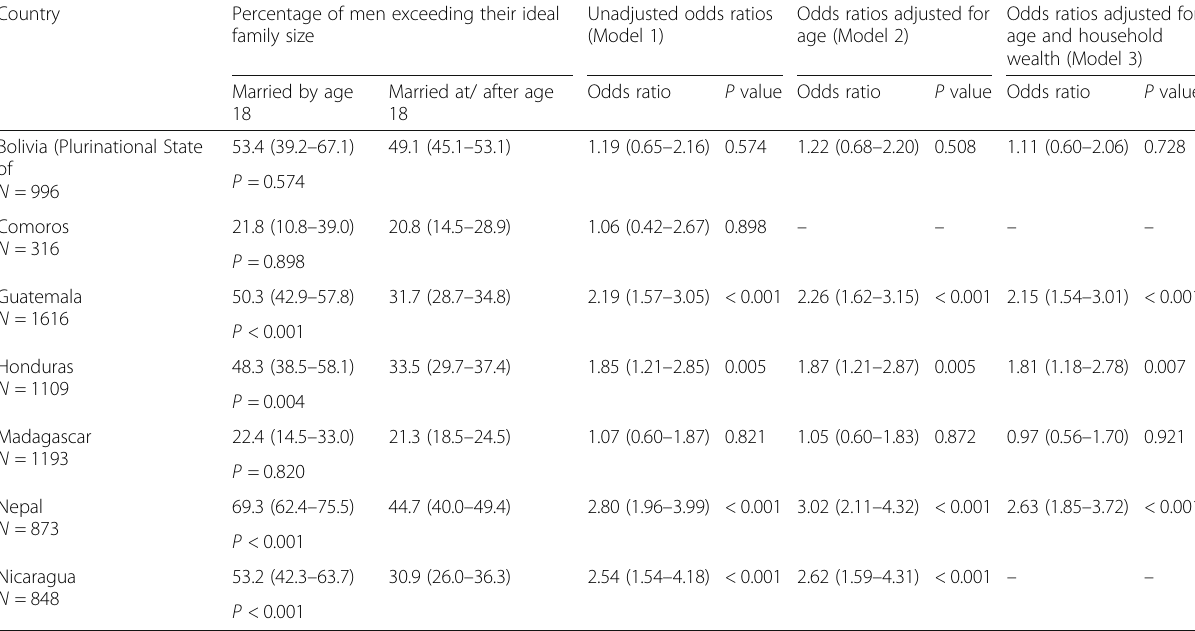
Table 9 Odds of having exceeded one ’ s ideal family size based on the total number of living children at the time of survey, comparing men currently aged 40 – 49 who were married by age 18 with those married at or after 18 (reference